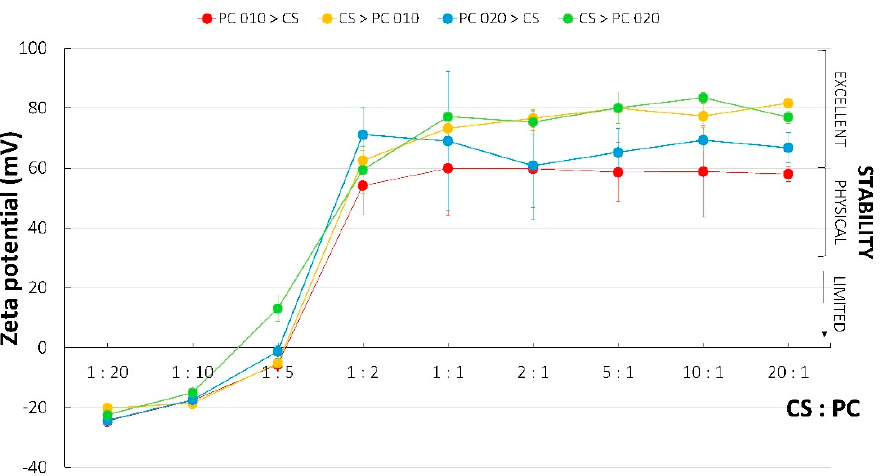
Figure 9. Changes of zeta potential noted for CS/PC mixtures with different polymer ratio and polyelectrolyte deposition. The range of zeta potential being characteristic of excellent, physical, and limited stability was also marked [42] (mean ± SD, n = 3).